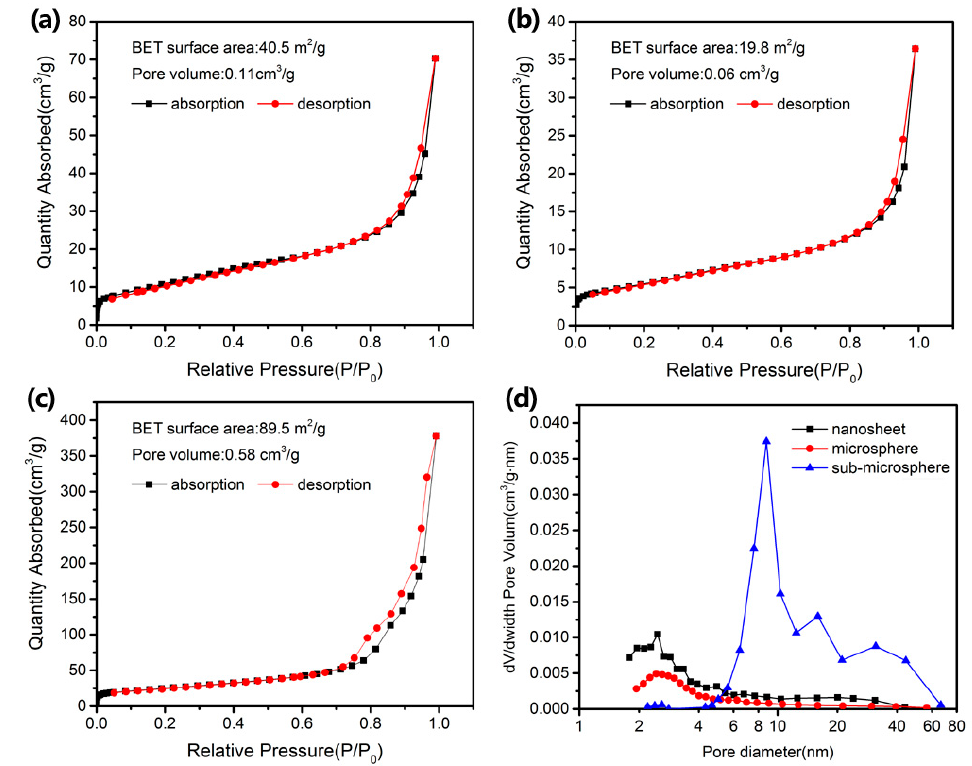
Figure 5. ( a ) N 2 adsorption–desorption isotherm curves of NiO nanosheet; ( b ) N 2 adsorption– desorption isotherm curves of NiO microsphere; ( c ) N 2 adsorption–desorption isotherm curves